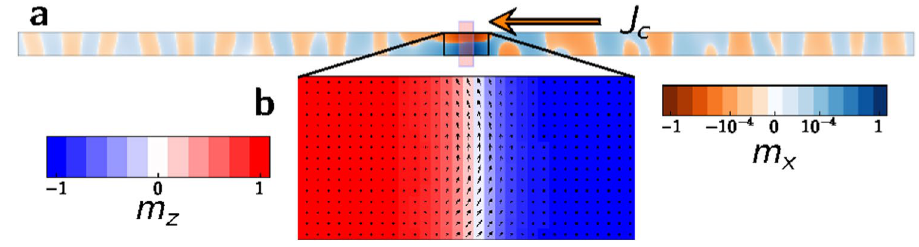
Figure 9. Non-geometrical constriction produces bidirectional SW emission. ( a) Snapshot of the magnetization dynamics showing the − x component of the magnetization when a DW is forced to rotate via the 10 2 . The pinning is realized via a decrease of 20% in uniaxial application of a current density = × − J 9 10 Am c anisotropy constant k in the shaded region. ( b) Close view of DW mangetization distribution. The DW u stretches across the whole wire width and its rotation is no longer uniform, causing a more irregular SW excitation and